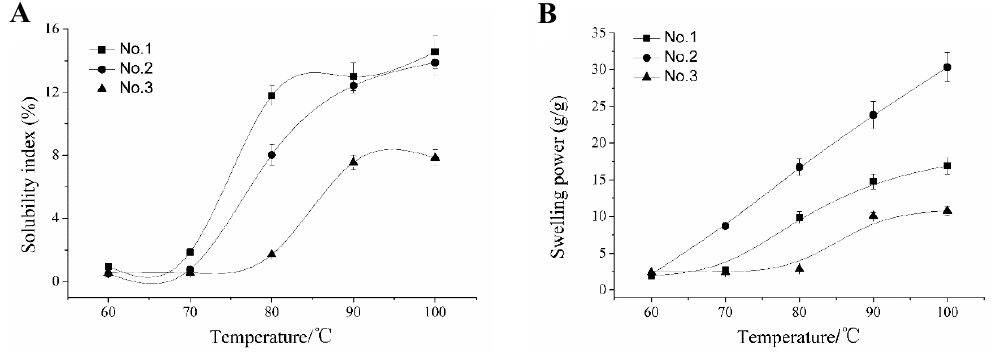
Figure 3. The solubility index ( A ) and swelling power ( B ) of CYYS-1, CYYS-2, and CYYS-3 at different temperatures. CYYS-1, CYYS-2, and CYYS-3 represent NO. 1-, NO. 2-, and NO. 3-Chinese yam starches in Yunlong town, respectively.